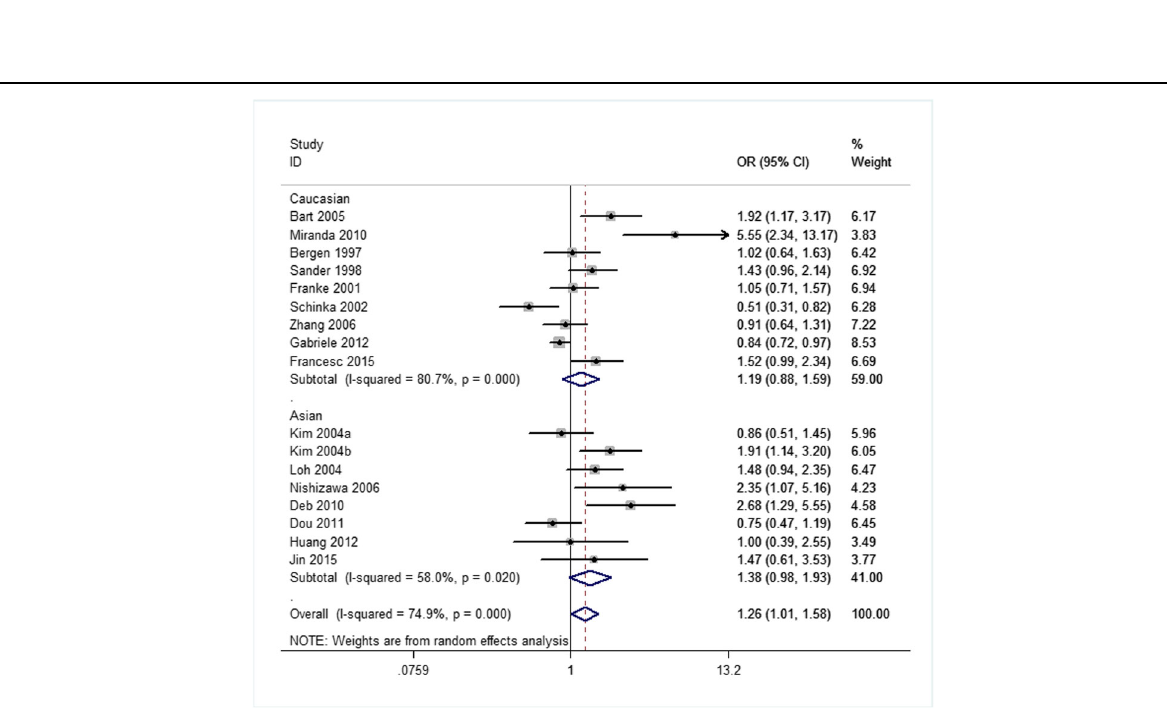
Fig. 6 Forest plots (individual and pooled effects with 95% CI) regarding the association of the OPRM1 A118G polymorphism with alcohol dependence in the dominant